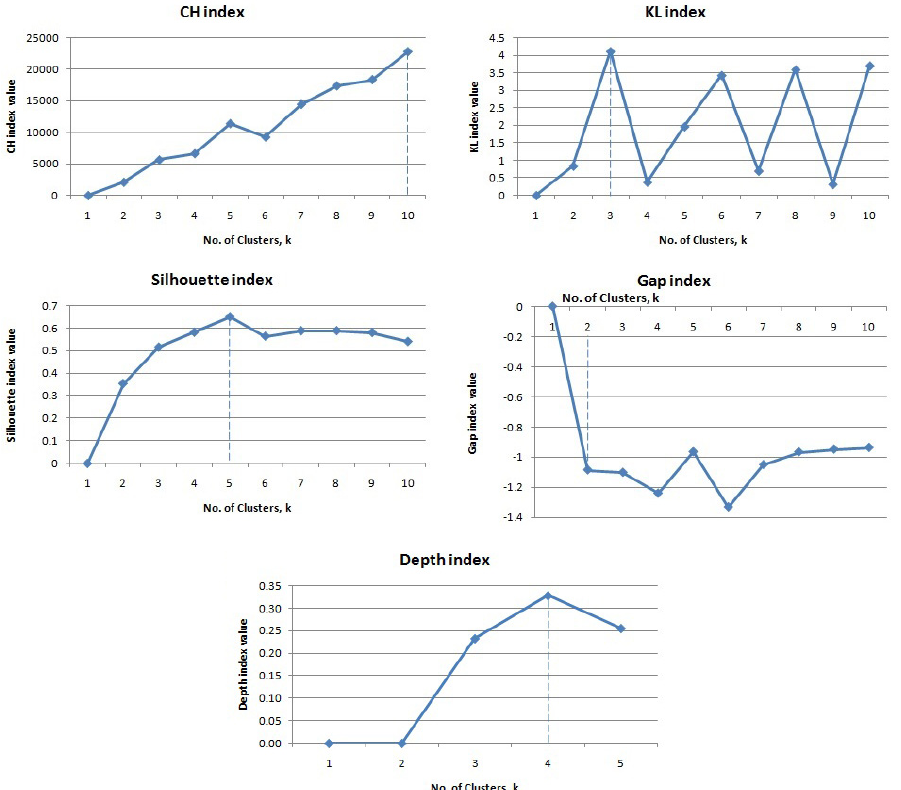
Fig. 3. Estimated k value based on the index values of CH, KL, Silhouette, Gap and Depth indices for